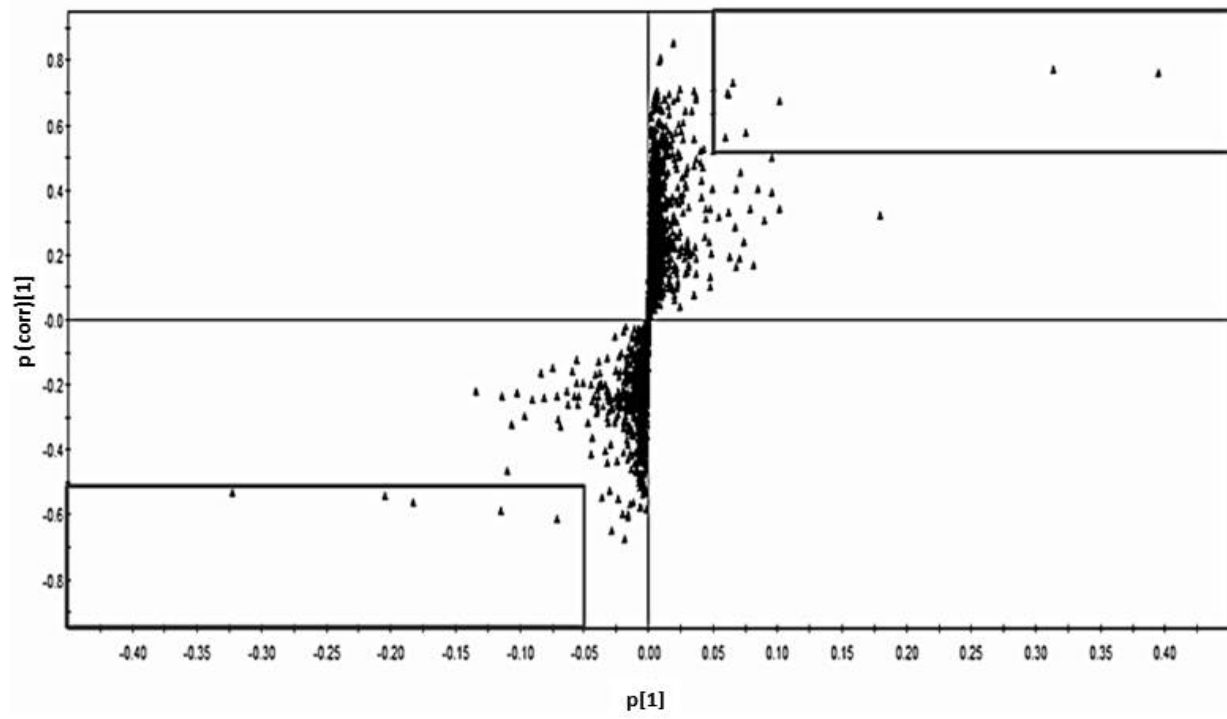
Figure 2. OPLS-DA S-plot of each variable that used a cut-off value for covariance of p ≥ |0.05| (magnitude) and p(corr) ≥ |0.5| (reliability), which indicates the most different compounds for each